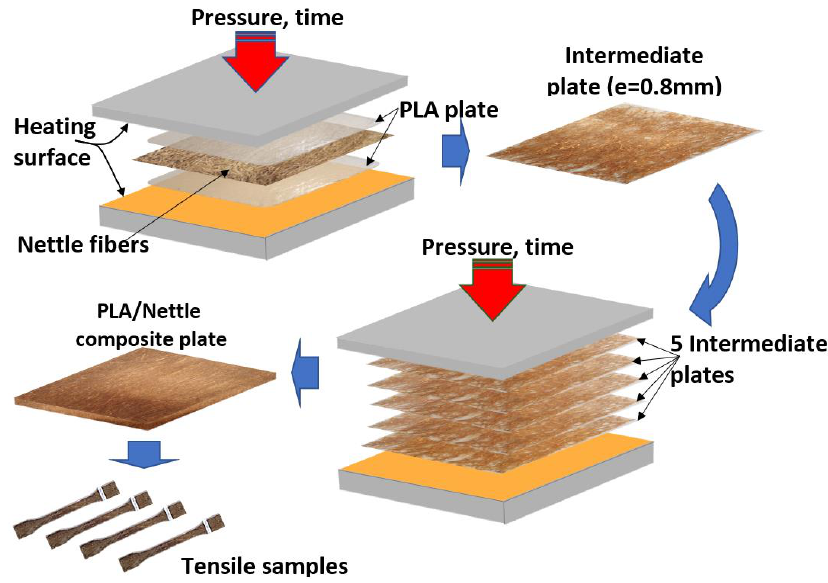
Figure 6. Manufacturing techniques used for agro-composite plates. PLA alone, intermediate plates, and final assembly of intermediate plates.